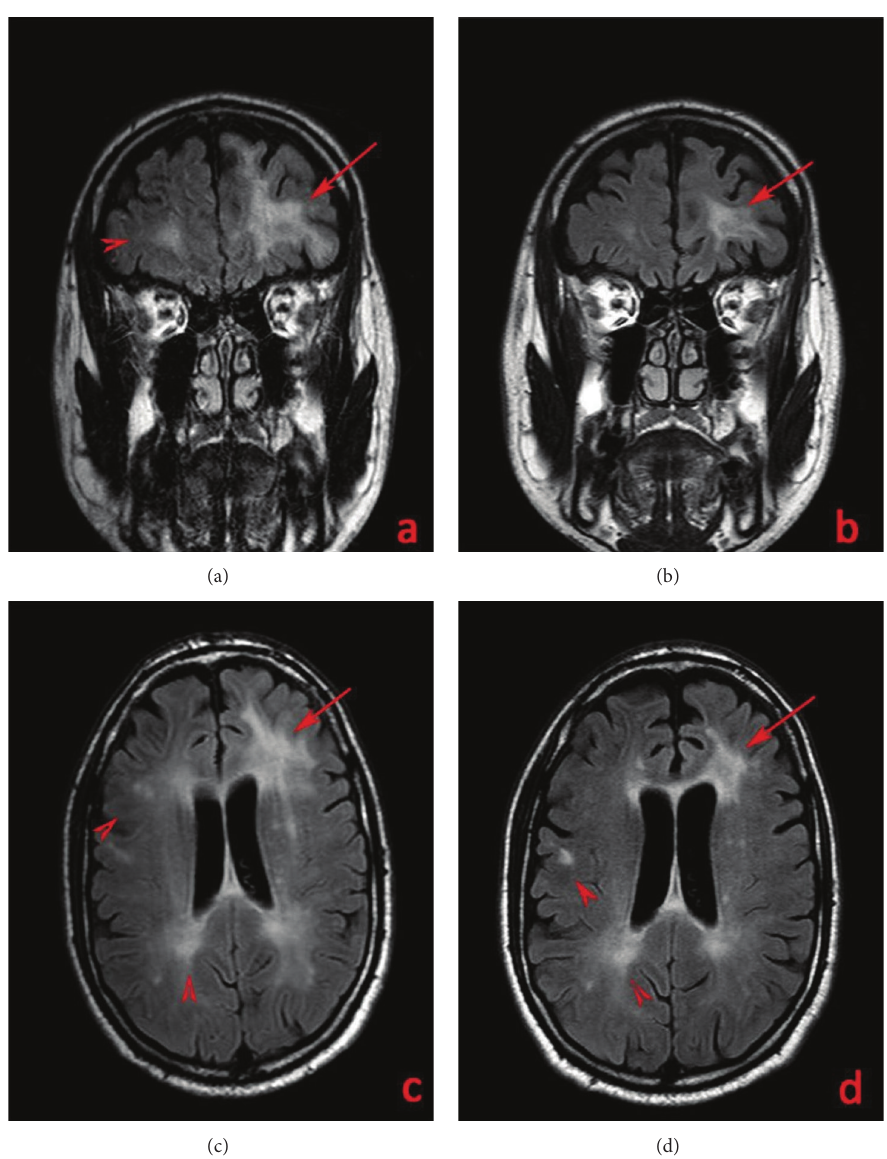
Figure 1: T2w FLAIR images (Philips Achieva 3T, TR = 9000 ms; TE = 123ms; inversion time TI = 2500 ms; FA 180). Juxtaventricular peri- and paratrigonal white matter lesion underneath the frontal lobe of the left hemisphere (arrows) in a 44-year-old man with a 12-year history of MS and affected by natalizumab-related PML in the coronal (a), (b) and axial plan (c), (d). Lesion reduction between December 2011 (a), (c) and May 2012 (b), (d). A bilateral white matter periventricular lesion load related to MS is also seen (arrow